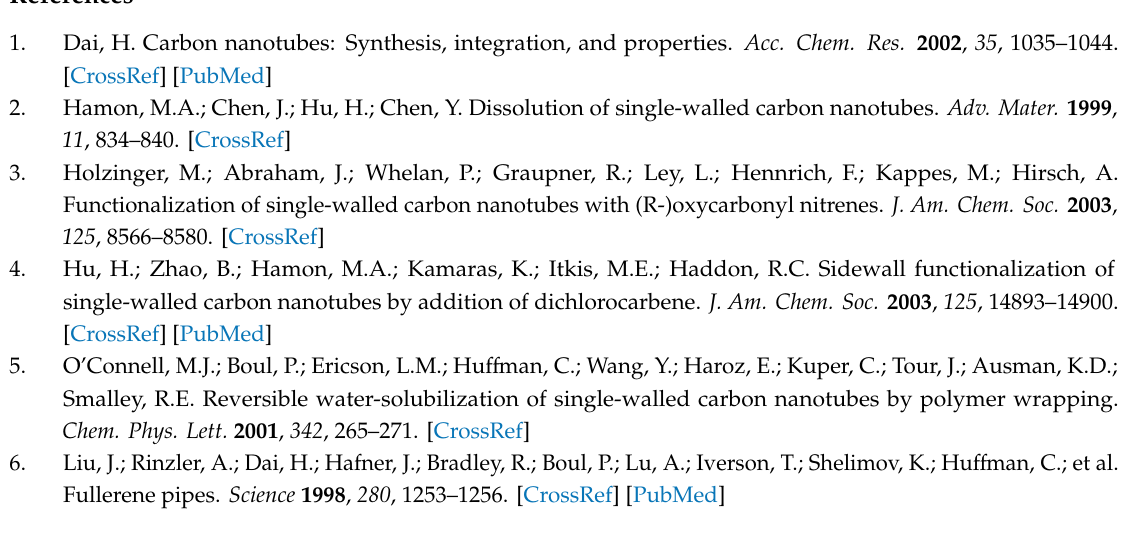
Figure S1: Voltametric behavior of [Fe(CN) 6 ] 3 − / [Fe(CN) 6 ] 4 − on CPEs modified with hydrogels; Figure S2: DPV response of Cd(II) in CPE modified with PAA-co-IA / NaOH / B-MWCNT hydrogel (solid line) and without modification (dot line) in solution of Cd(II) 1 × 10 − 3 M + KNO 3 0.1 M to a pulse reduction of − 0.95 V during 40 s, 33.3 mVs − 1 and pH 5, in argon saturated solutions; Figure S3: Estimation of the zero charge point of PAA-co-IA / NaOH and PAA-co-IA / NaOH / B-MWCNT hydrogels; Figures S4A and S4B: Voltametric behavior of Cd(II) on CPE modified with hydrogels adding di ff erent concentrations of the analyte; Figure S5: The calibration curves of Cd(II), at di ff erent concentration ranges on electrodes modified with PAA-co-IA / NaOH / B-MWCNT: A) 0.01 × 10 − 3 and 0.13 × 10 − 3 M (i.e., 1125 and 14,606 ppb); B) 0.9 × 10 − 3 and 2.1 × 10 − 3 M (i.e., 1.01 × 10 5 and 2.36 × 10 5 ppb); on electrode modified with PAA-co-IA / NaOH C) 0.1 × 10 − 3 and 0.9 × 10 − 3 M (i.e., 1.1 × 10 4 and 1.01 × 10 5